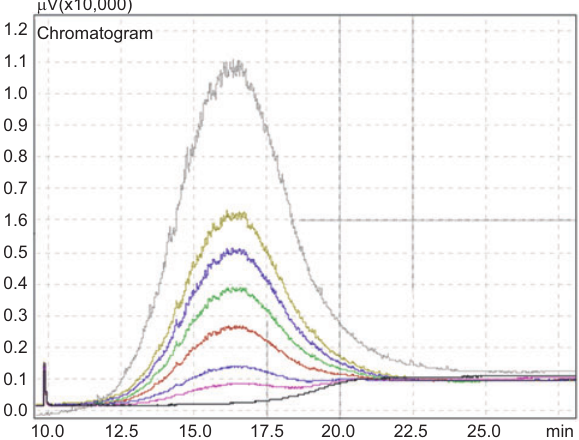
Figure 2 Chromatograms of the standard working oil solutions with increasing concentrations: ___ – cyclohexane 0.0 mg ml -1 –